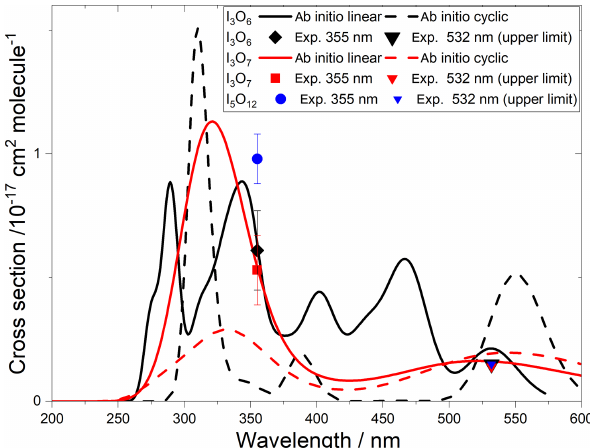
Figure 10. Absorption cross-section spectra of I 3 O 6 (black lines and symbols), I 3 O 7 (red lines and symbols), and I 5 O 12 (blue sym- bols). Ab initio spectra of linear and cyclic isomers are shown by solid and dashed lines,